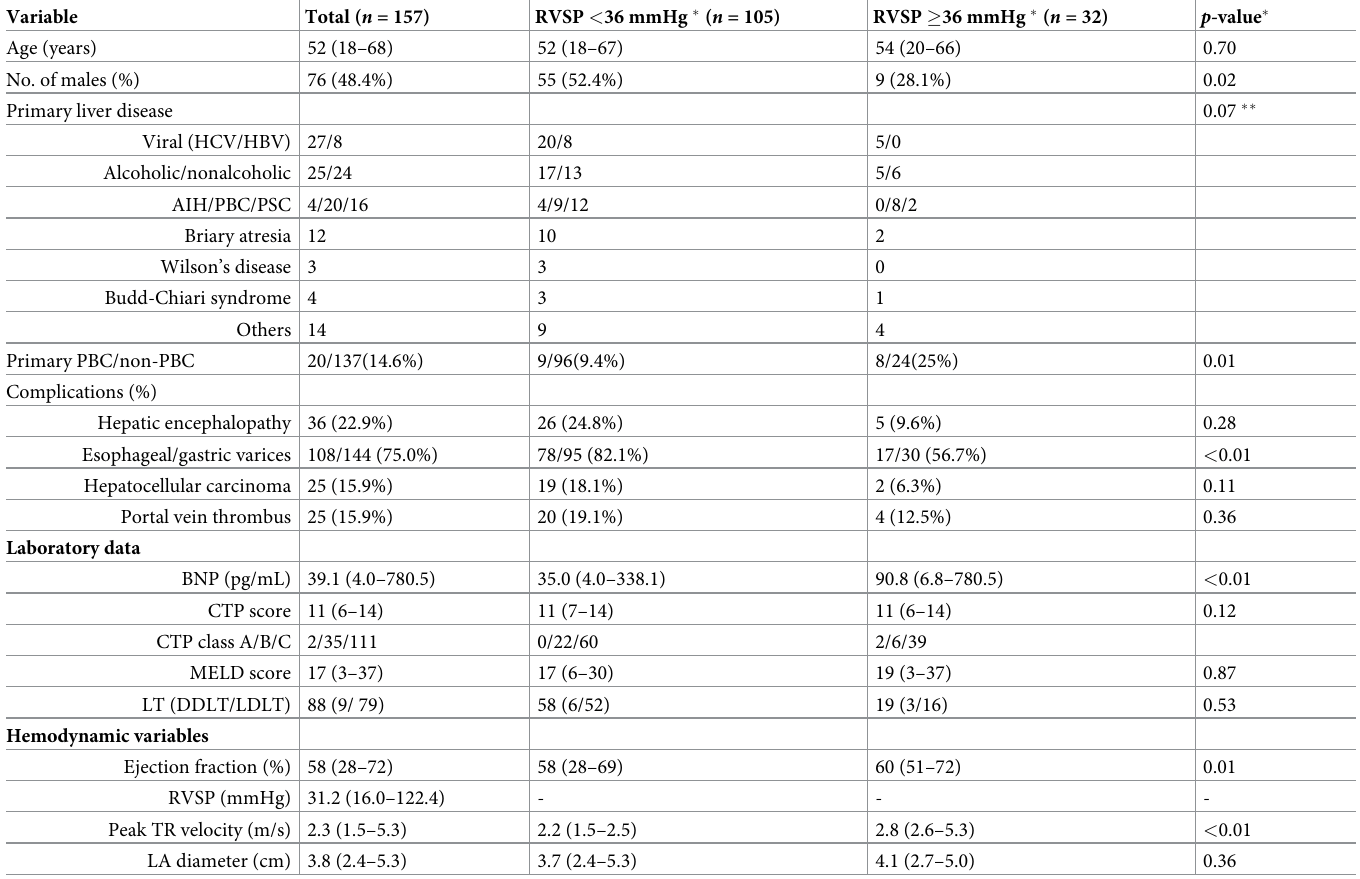
Table 1. Baseline characteristics of the